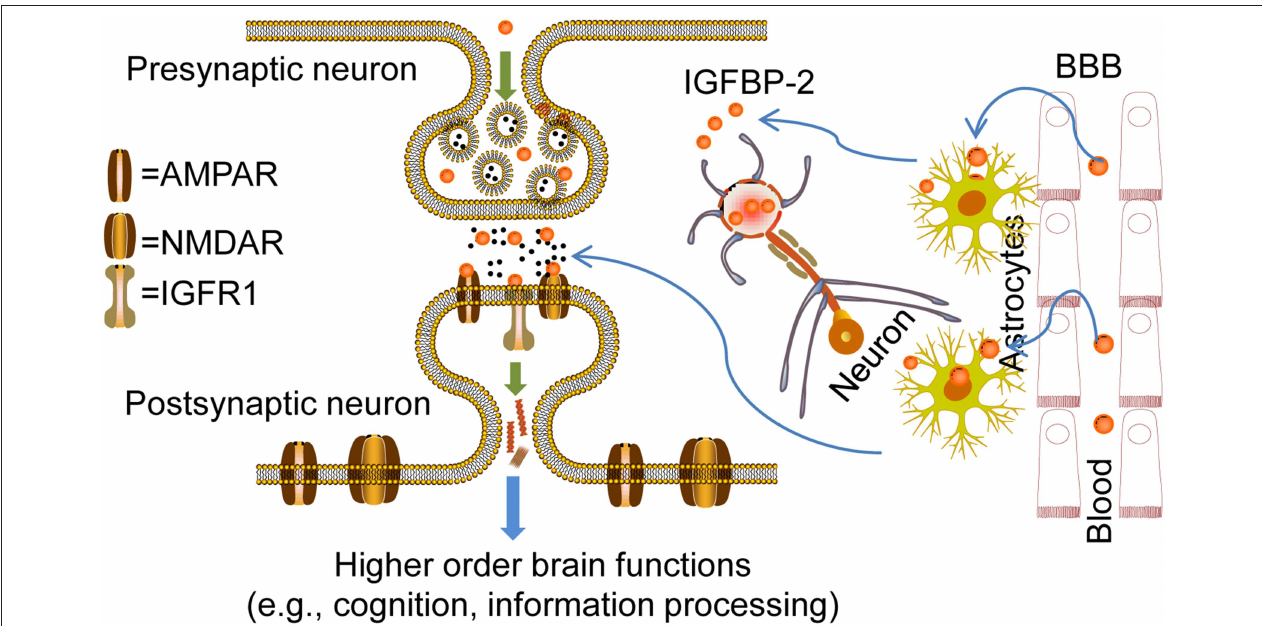
FIGURE 6 | Overview of IGFBP-2 action in CNS for higher order brain functions. Probable mechanisms for the entry of IGFBP-2 across the blood-brain barrier (BBB) to cerebrospinal fluid (CSF): Transport could happen via transcytosis through the choroid plexus where low-density lipoprotein receptor-related proteins-1/2 (LRP-1/2) and IGF-IR may play a crucial role in IGFBP-2 entry from blood to CSF. In this type of entry, concentrations of IGFBP-2 in the blood determine entry. IGFBP-2 in the CSF interacts with IGF-IR in the hippocampus because of its location adjacent to the ventricular system. IGFBP-2 released from astrocytes in response to any kind of CNS insult may directly interact with IGF-IR and be involved in the CNS repair process, neural development, and growth. On the other hand, IGFBP-2 in the neurons is released upon neuronal excitability. In this case, IGFBP-2 may directly bind with the receptors such as AMPAR, GABAR, and NMDAR in the dendrites and axon terminals to mediate synaptic plasticity mechanisms for higher-order brain function, from information processing to cognition. In addition, IGFBP-2 may phosphorylate different ion channels by phosphoinositide 3-kinase (PI3K) or extracellular signal-related kinases (ERKs). IGFBP-2 synthesized inside the neurons may regulate the synthesis of synaptic proteins by direct localization into the